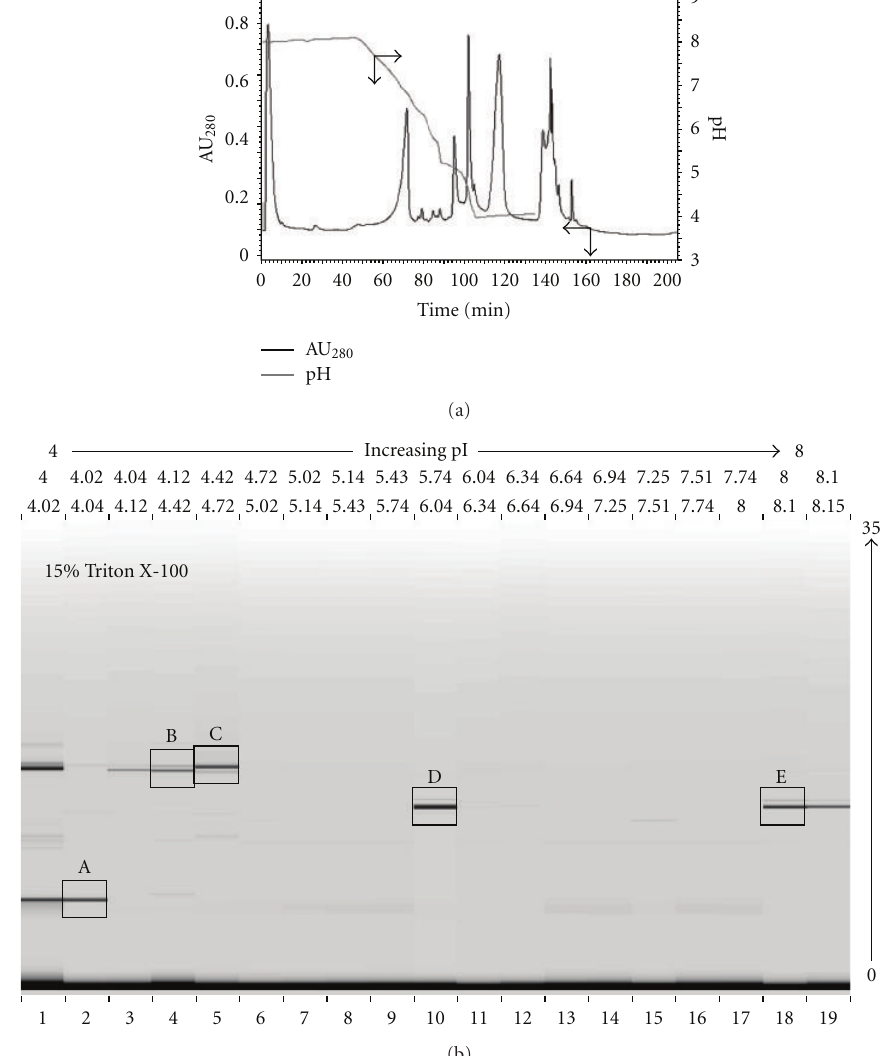
Figure 3: PF2D results of Beckman Coulter’s protein test mixture containing five proteins (Ribonuclease A, insulin, α -lactalbumin, trypsin inhibitor, cholecystokinin (CCK)). (A) First-dimension elution profile of five proteins generated using 0.15% Triton X-100 over 200 min. The elution profiles were monitored at 280nm. (B) ProteoVue 2D map of five proteins having pI 8.15–4.00 eluted in the order of increasing hydrophobicity. The fraction profiles were monitored at